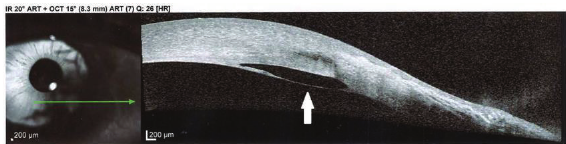
Figure 3: SPECTRALIS SD-OCT photograph of right eye showing partial detachment of Descemet’s membrane (solid white arrow), cyst formation, and peripheral thinning.